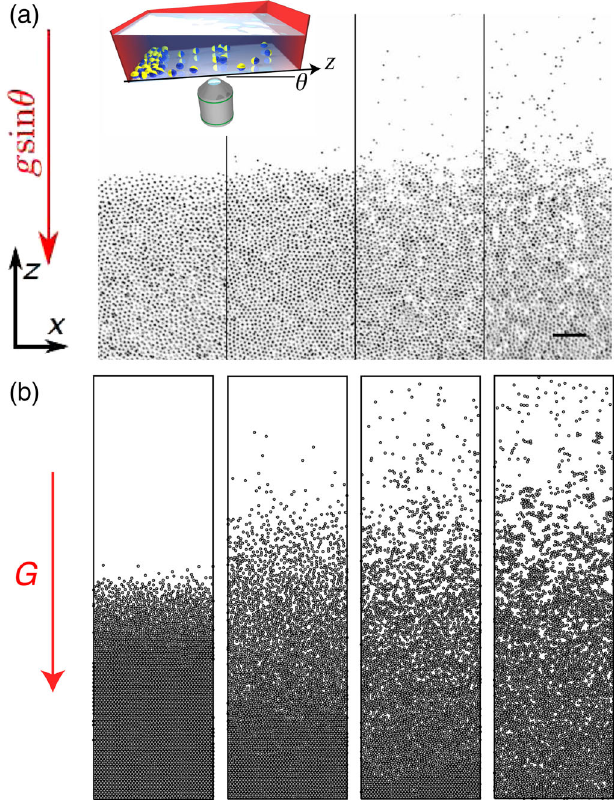
FIG. 1. Imaging sedimentation profiles. Snapshots of (a) pho- retic gold-platinum Janus colloids and (b) self-propelled hard disks under gravity for activity increasing from left to right. (a) Four different activities are shown, corresponding to Péclet ¼ 0 (passive case), 8, 14, and 20 (from left to right). numbers P e The inset shows a schematic view of the experimental setup. The scale bar is 20 μ m. (b) Simulation snapshots for persistence times τ ¼ 0 (passive disks), 1, 10, and 100 (from left to